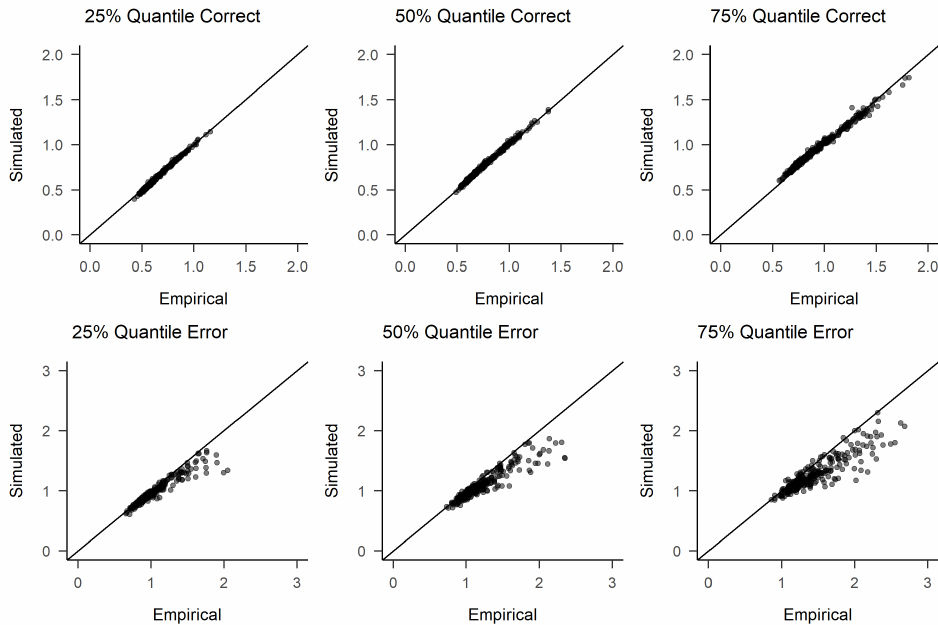
Figure A1. Posterior predictive check of RTs for T2. Participants with 10 or less errors are omitted from the error response time plots.